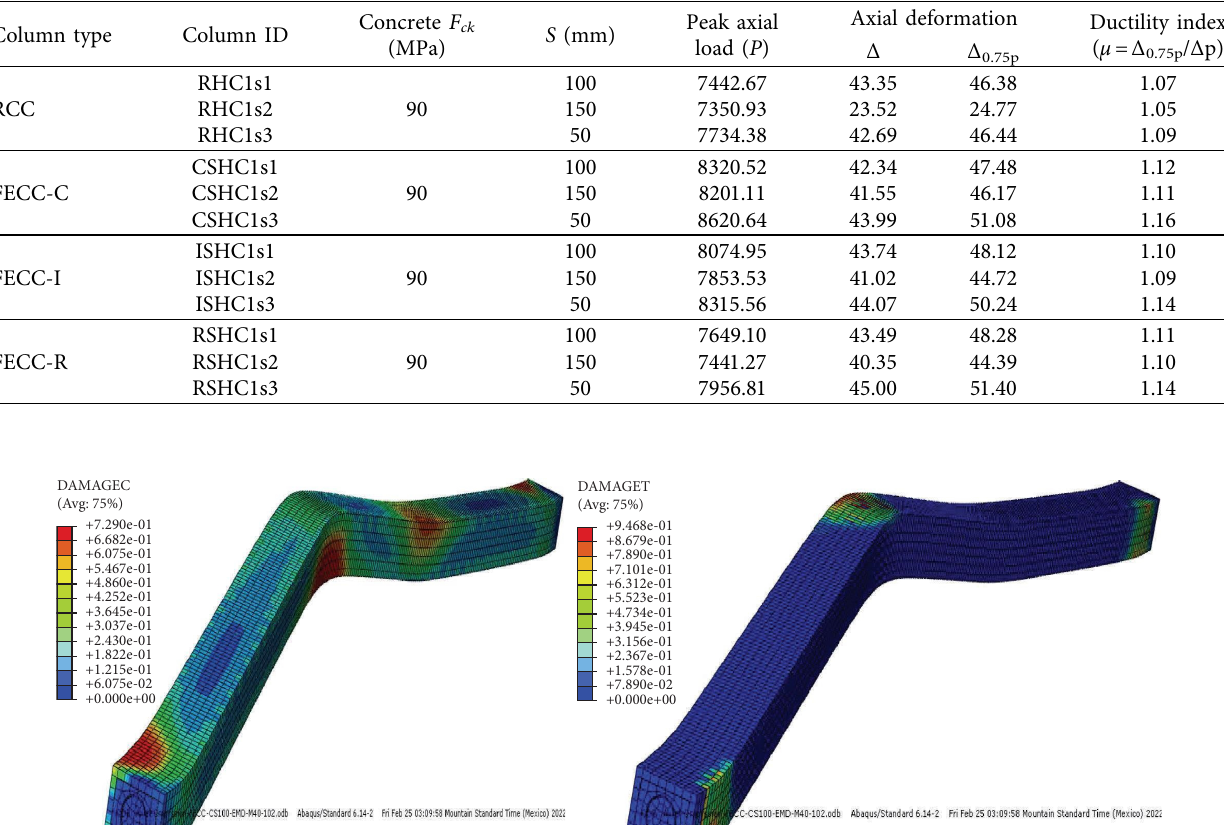
Table 14: Ductility index of columns due to spacing of tie bars.